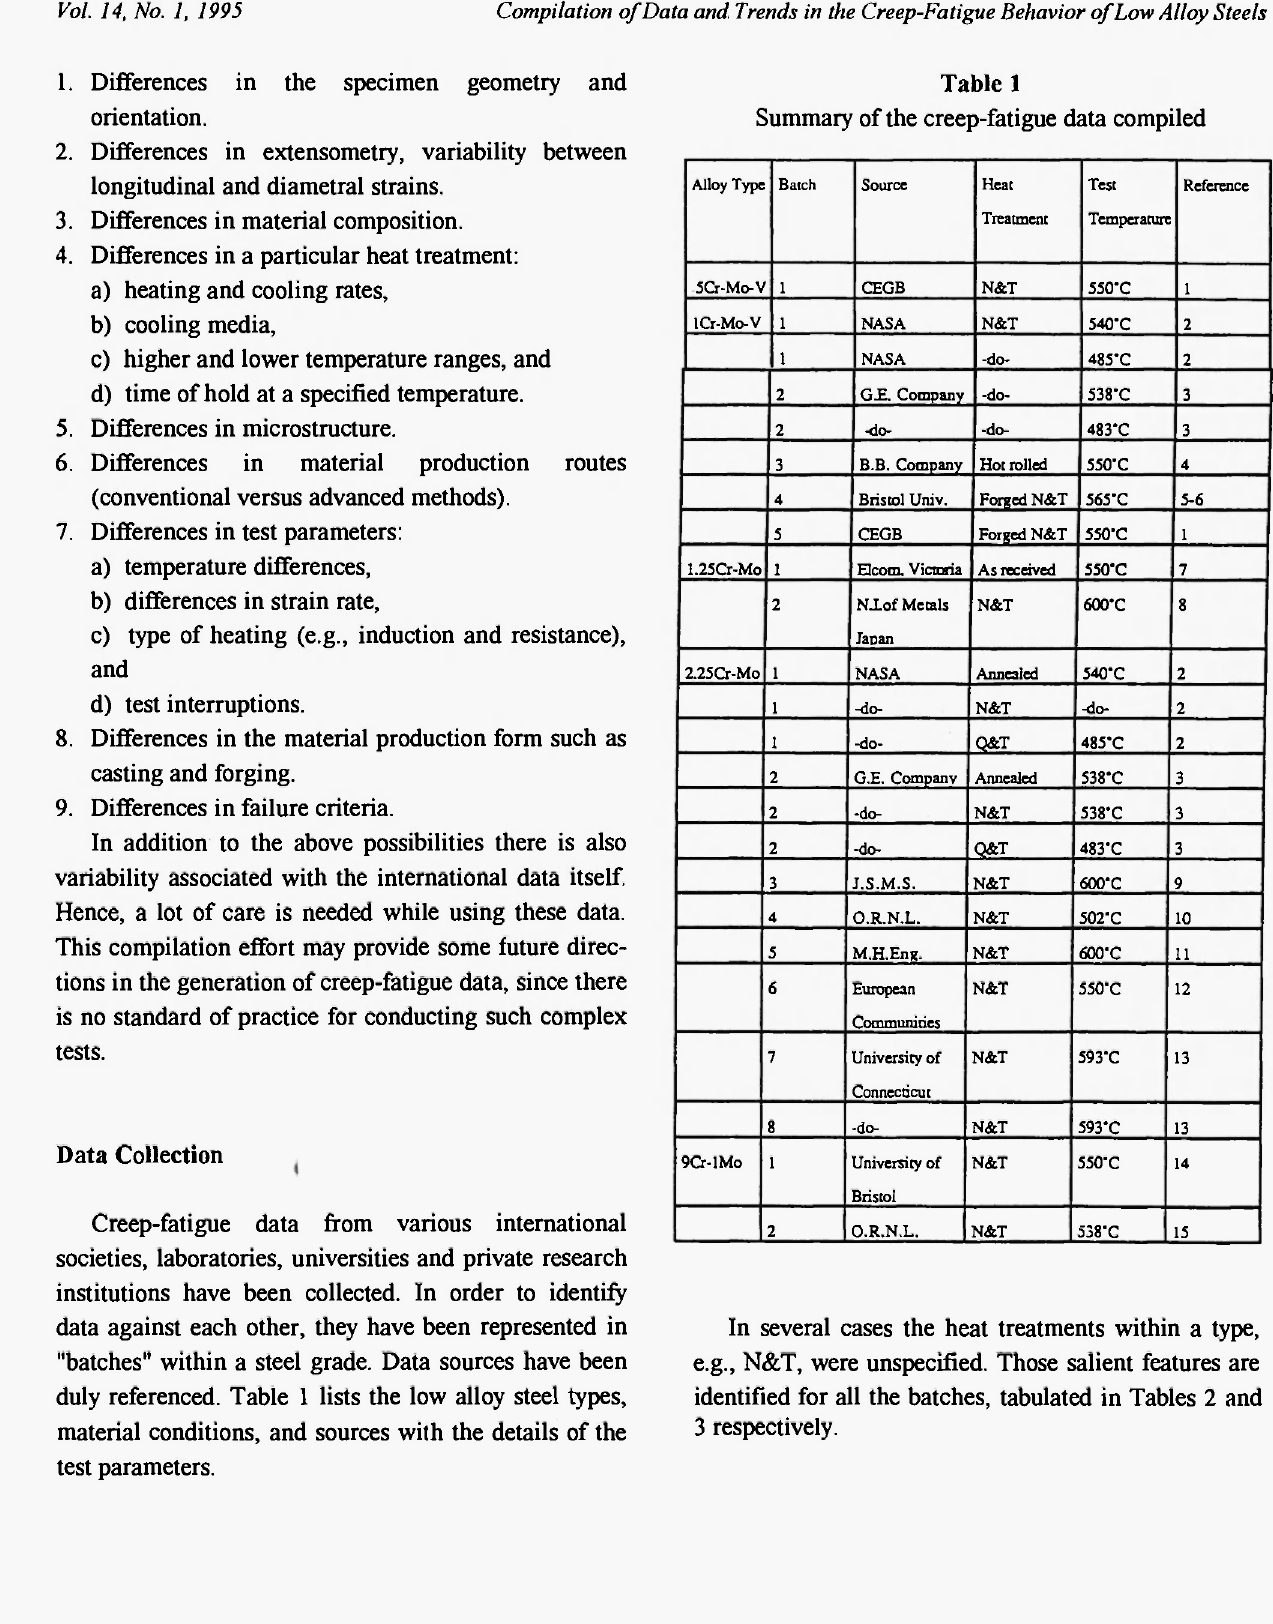
Summary of the creep-fatigue data